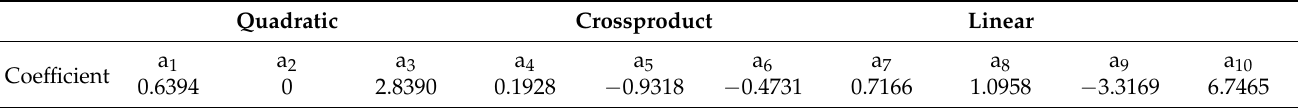
Table 3. Regression coefficients of predicted quadratic polynomial